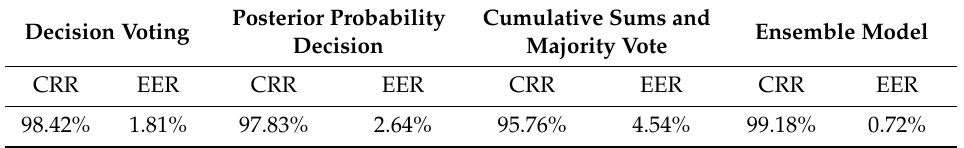
Table 6. The CRR and EER in decision layer